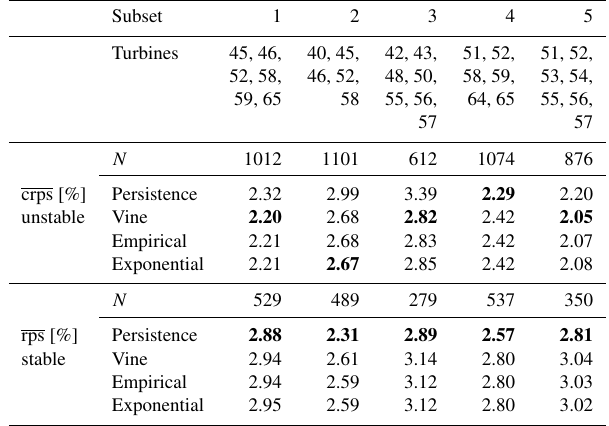
Table 2. The RMSE (% of the subsets’ rated power) for the vine, empirical and exponential copula approaches, the deterministic ap- proach, and persistence for unstable and stable atmospheric condi- tions. The lowest scores are shown in bold.